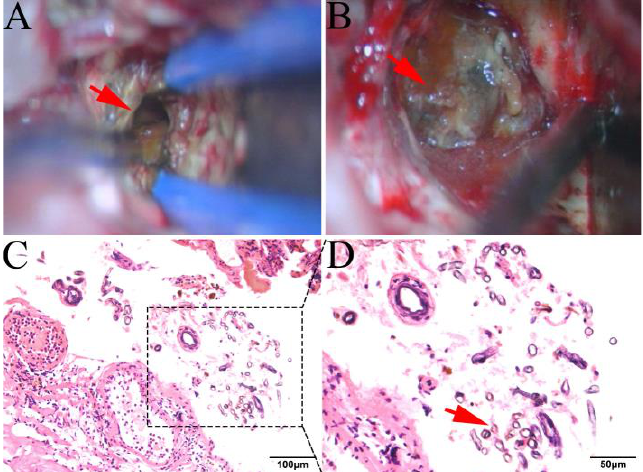
Figure 3. General and microscopic features of the space-occupying intracranial fungal lesion. ( A , B ) Intraoperative pictures showing the fungal lesion with cyst formation: ( A ) after draining out the cystic fluid; red arrow shows the cyst cavity; ( B ) before the cyst was almost totally resected; red arrow shows the cyst wall. ( C , D ) H&E staining results show that fungal spores and eosinophils are seen in the inner side of the cyst wall; red arrow shows the spherical and partly rod-shaped fungus.